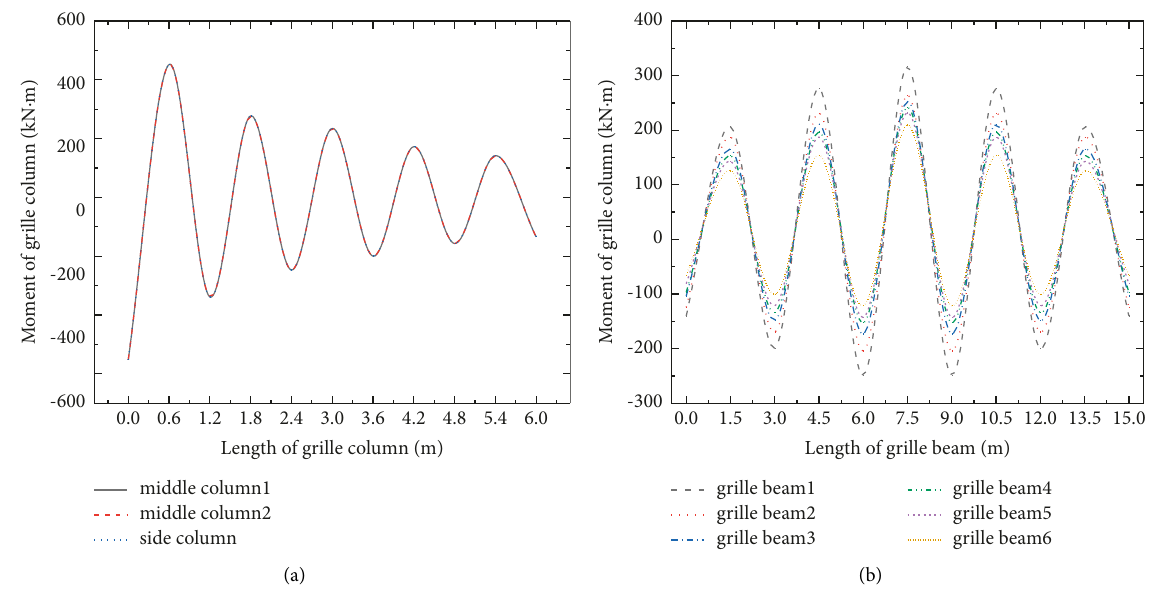
Figure 9: Consider the overall coordination. (a) Bending moment diagram of grille column. (b) Bending moment diagram of grille